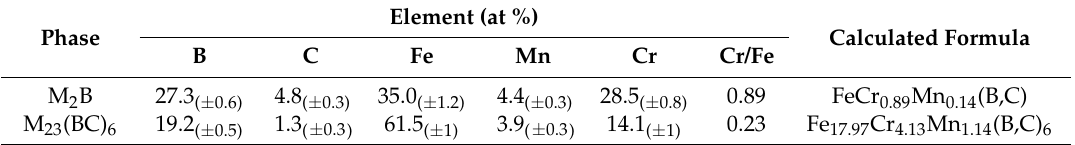
Table 2. Compositions of the M 2 B and M 23 (B,C) 6 measured by using an electronic probe microanalyzer (EPMA).